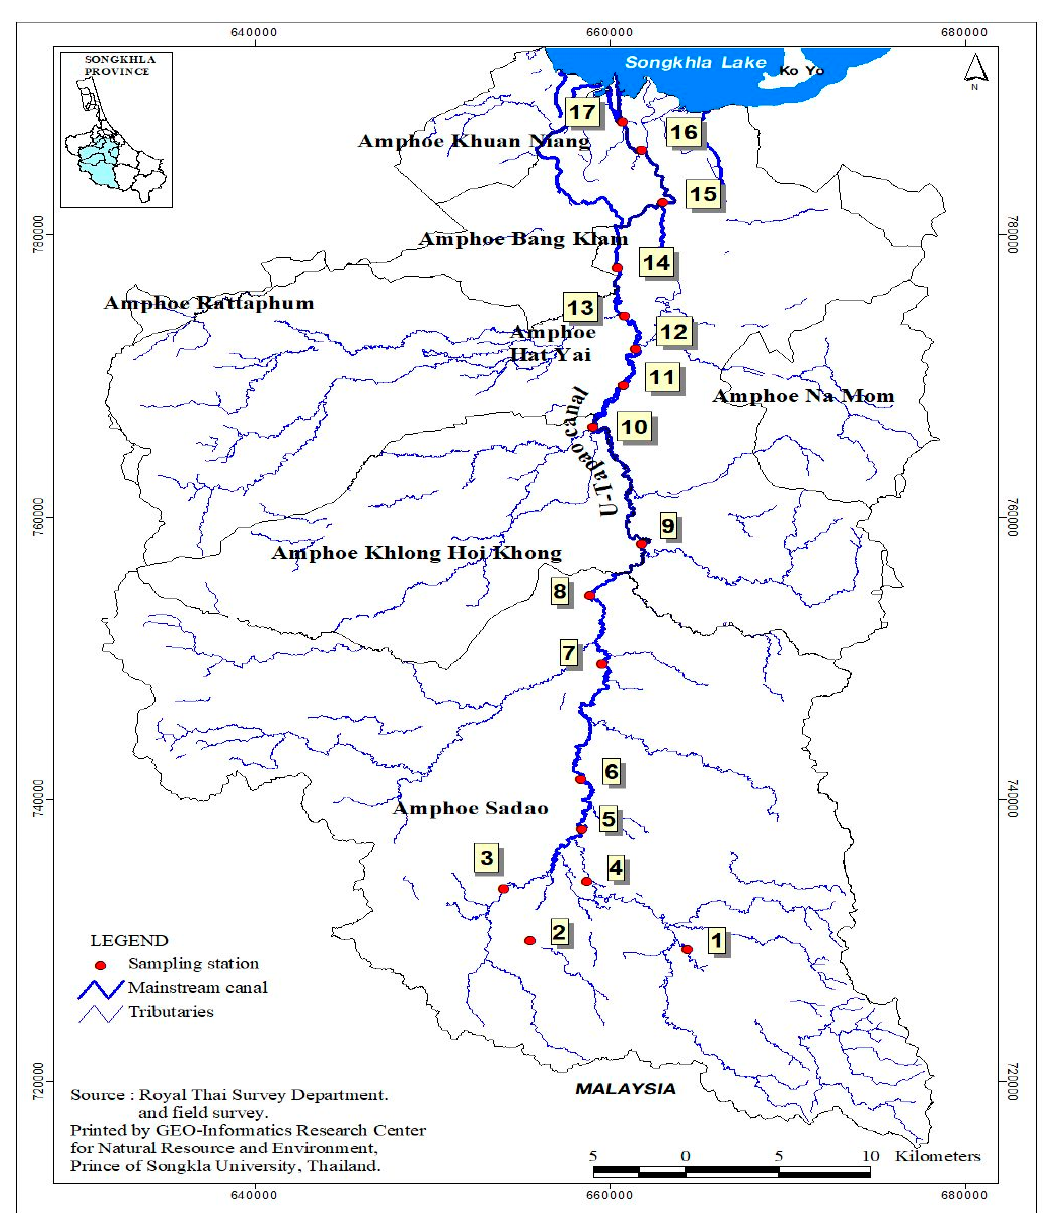
Figure 1. Map showing sampling sites of sediments in U-Tapao canal. (Source: Geoinformatics Research Center, Prince of Songkla University, 2019).